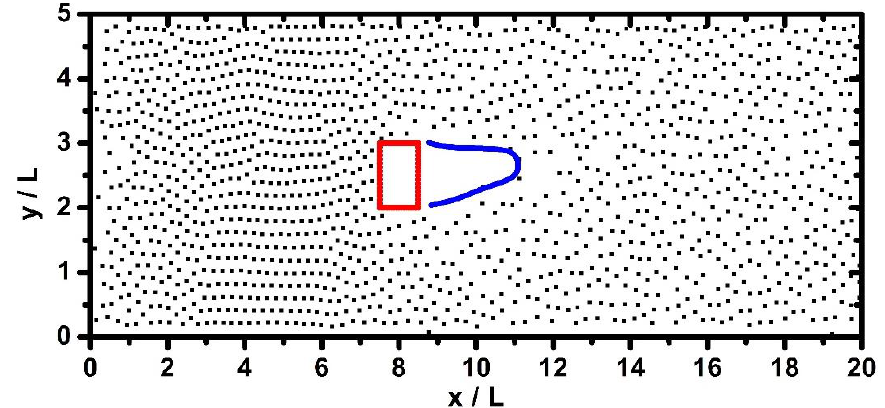
(a) Particles distributions for the new boundary